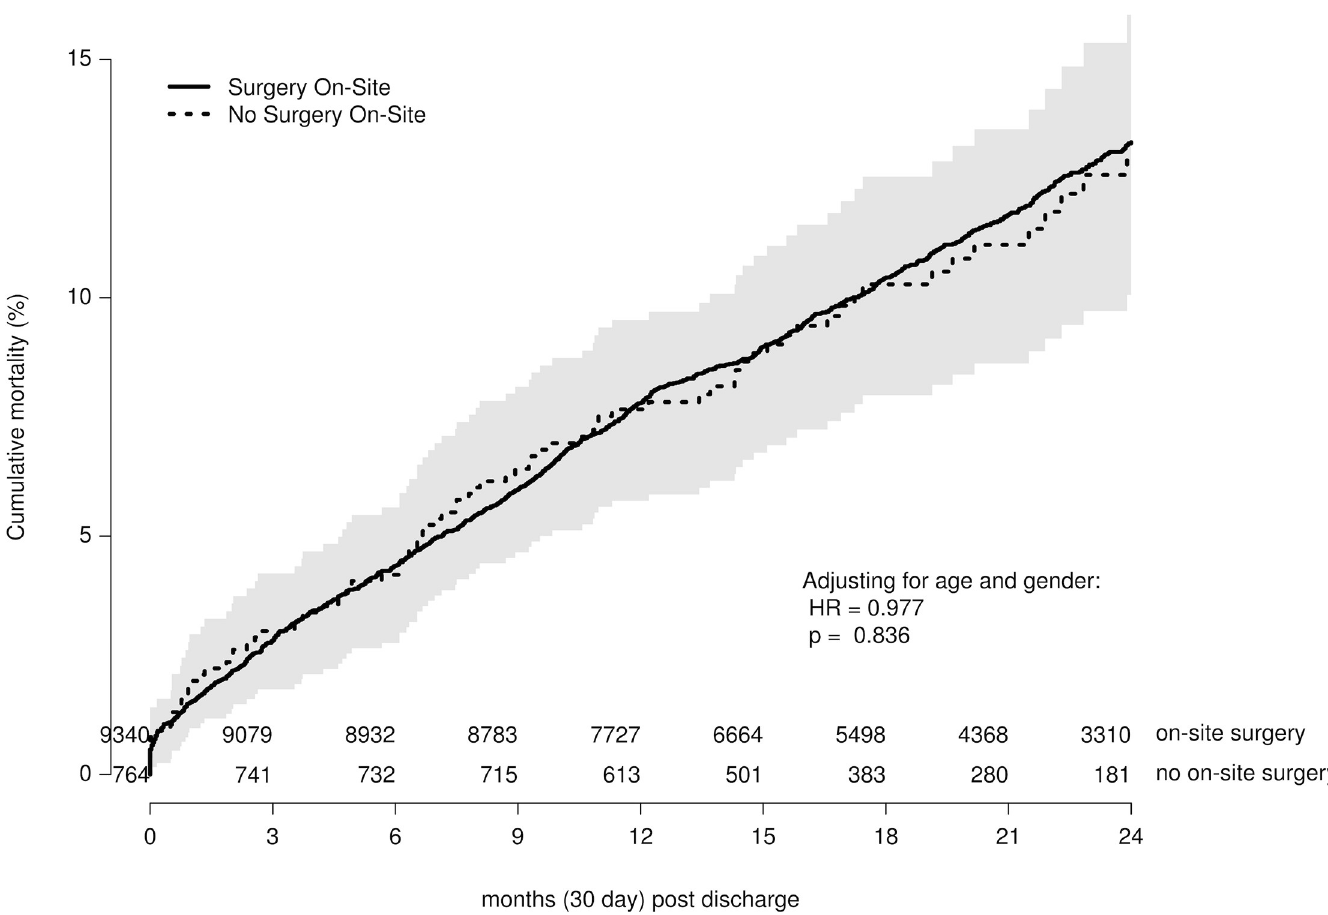
Fig 3. Long-term mortality of patient at sites without surgery on-site. Kaplan-Meier curve of long-term mortality among subset of matched Medicare patients at sites with (solid line) and without (dotted line) surgery on-site. Curve demonstrates no significant difference in overall time to post-discharge mortality. The solid gray bars represent the 95% confidence interval around the estimates of cumulative